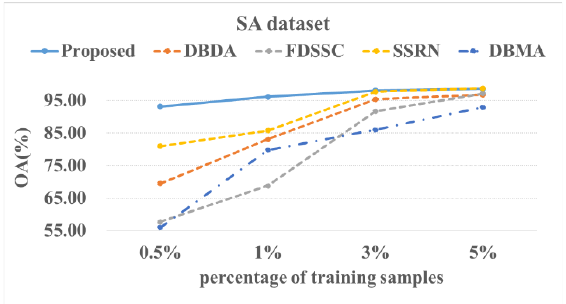
Figure 16. OA results of the different methods from various proportions of training samples using the SA